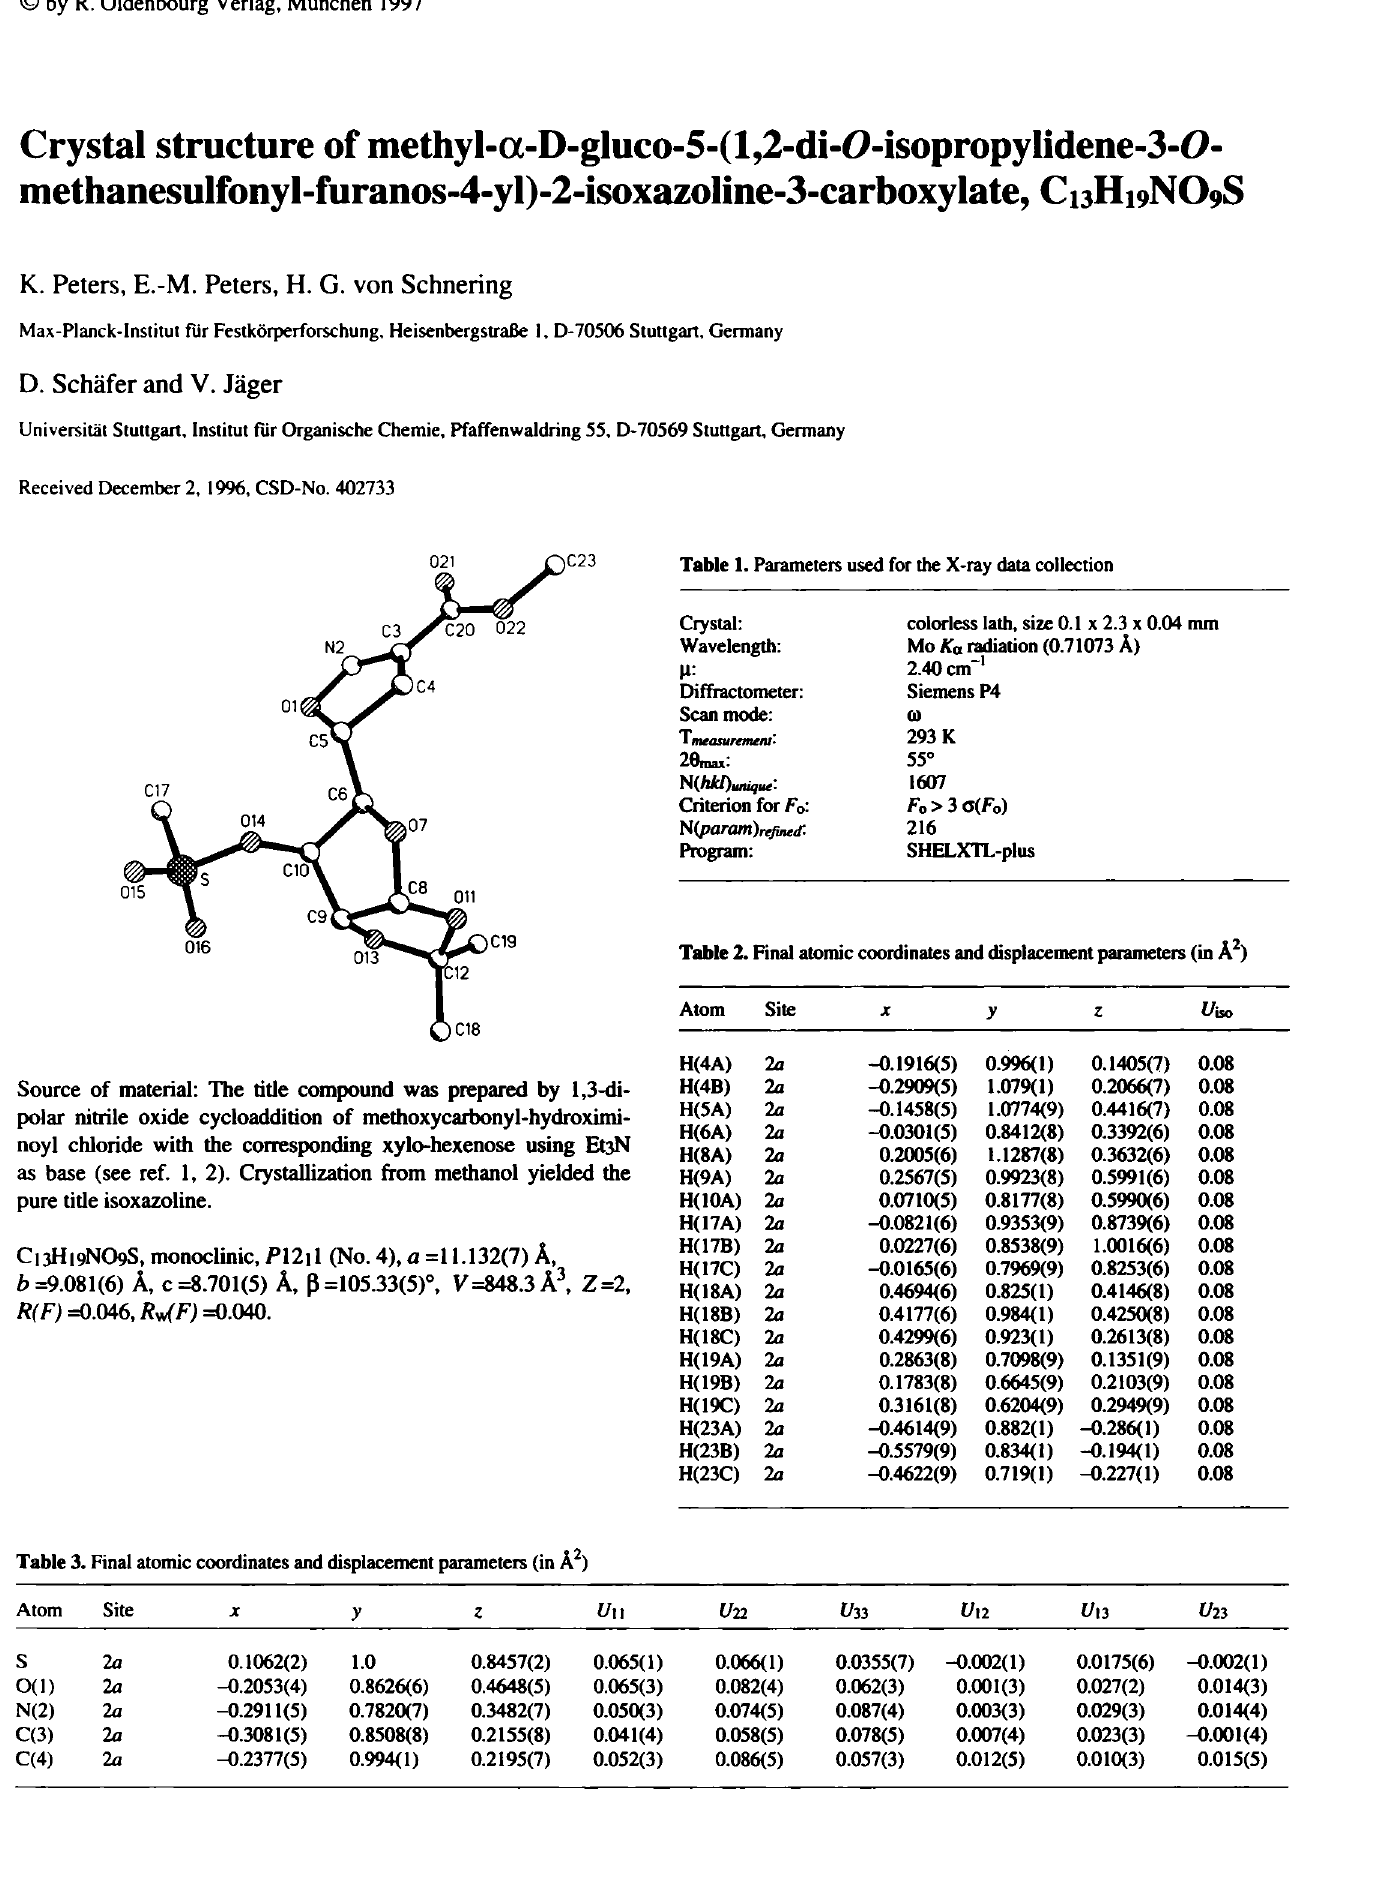
Table 1. Parameters used for the X-ray data collection Crystal: